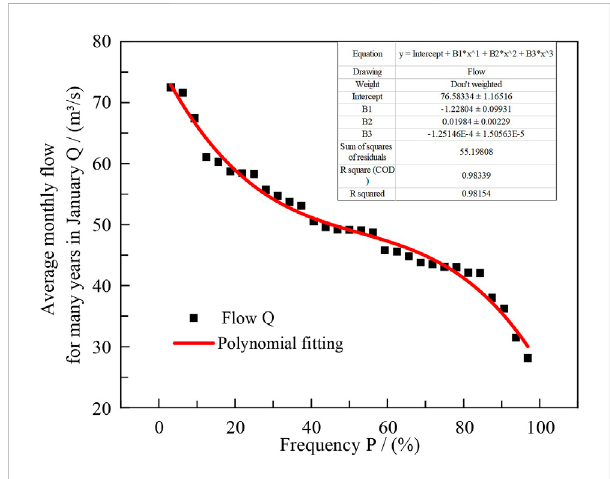
FIGURE 3 Cumulative frequency corresponding to multi-year average runoff in